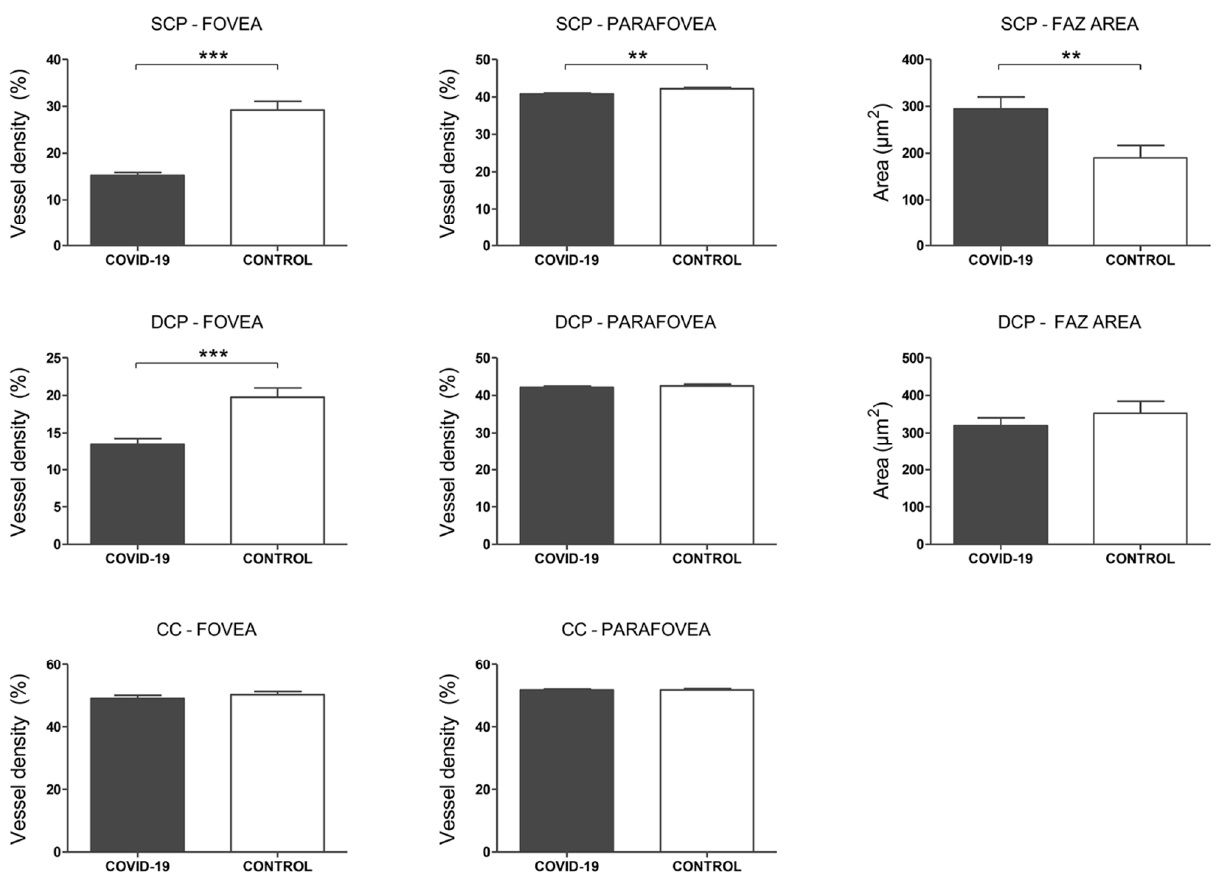
Figure 5. Optical coherence tomography angiography (OCTA) analysis. Top row: Superficial capillary plexus (SCP) analysis. Mean vessel density (%) of the foveal and parafoveal regions. Foveal avascular zone (FAZ) area. Middle row: Deep capillary plexus (DCP) analysis. Mean vessel density (%) of the foveal and parafoveal regions. Foveal avascular zone (FAZ) area. Bottom row: Choriocapillaris (CC) analysis. Mean vessel density (%) of the foveal and parafoveal regions. p -values correspond to a comparison between COVID-19 patients and controls. Error bars correspond to the SEM. ** p < 0.01, *** p < 0.001.